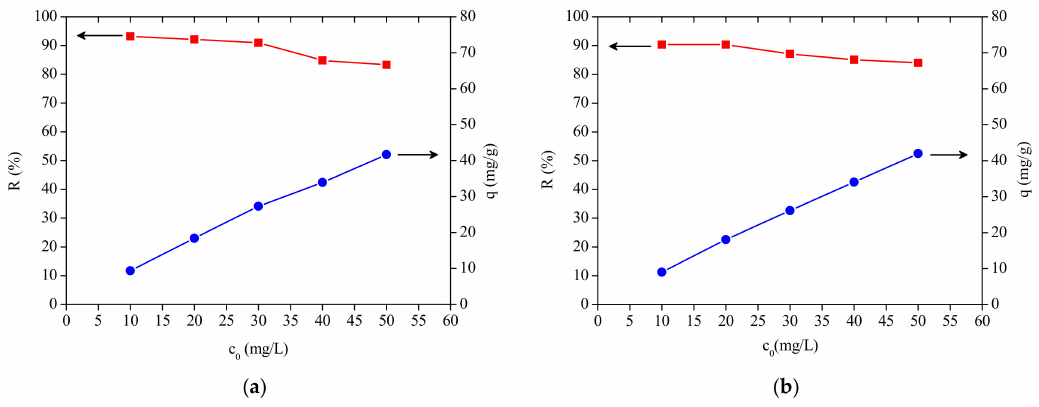
Figure 4. Initial concentration vs. percentage of removal vs. biosorption capacity: ( a ) PMT and ( b )